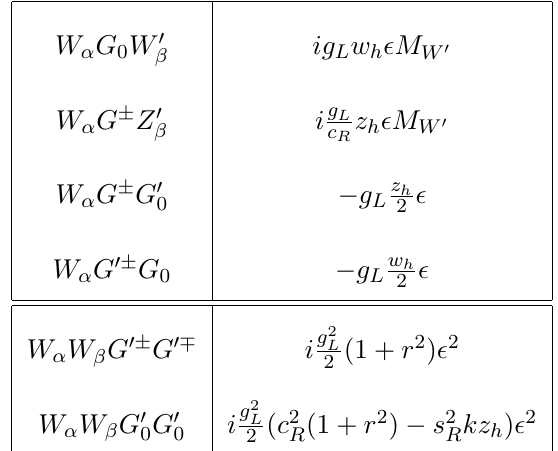
Table 18 . Triple and quadruple gauge couplings involving a W boson and at least one unphysical Goldstone boson. Only the couplings contributing at (cid:15) 2 to (cid:1) r are shown. All these couplings are multiplied by g (cid:11)(cid:12) except the triple couplings to two unphysical gauge bosons which are multiplied by ( p (cid:6) (cid:0) p 0 ) (cid:11) with p (cid:6) ; 0 the incoming momenta of G (cid:6) ; 0 .